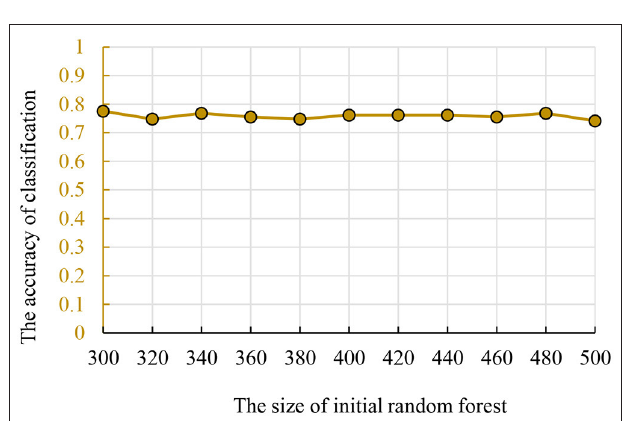
FIGURE 4 | The relationship between the accuracy and initial random forest